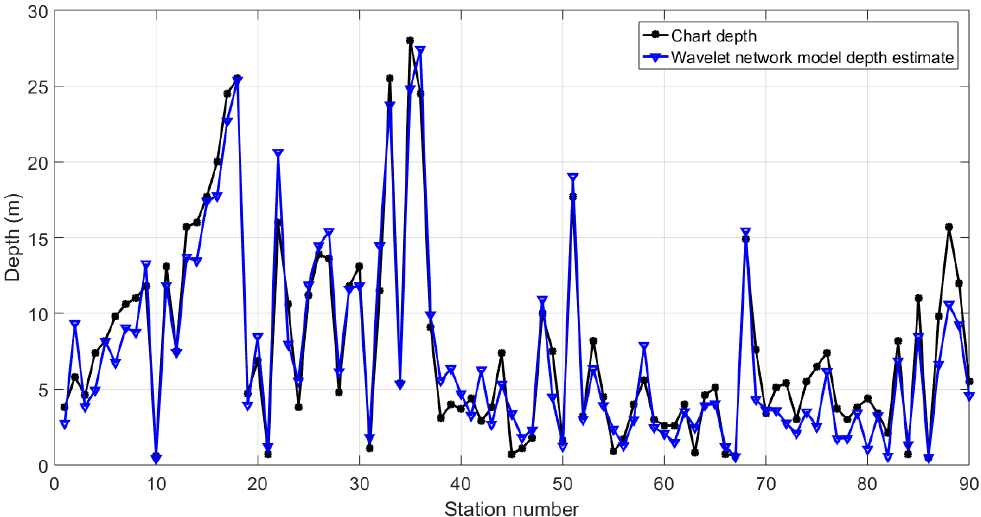
Figure 6. The modelled and validated model depth estimates versus the “truth” nautical chart depths values for the 90 collocated stations using the wavelet network model.